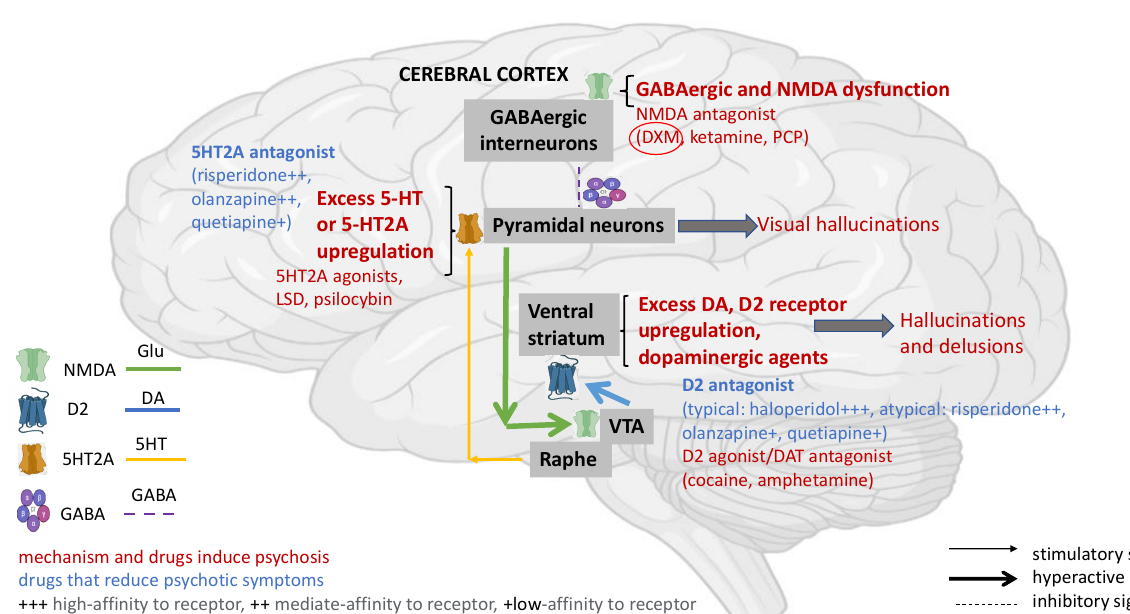
Figure 2. Potential drug-related psychosis pathways. Neurobiological and pharmacological evidence has revealed that psychosis symptoms, such as hallucination and delusions, are mediated by overactivation of the mesolimbic pathway, while visual hallucinations are consequences of visual cortex overstimulation. NMDA receptor dysfunction, excessive serotonin (5-HT) release, or 5-HT2 upregulation in the cerebral cortex may be the causes of further sustained activation of pyramidal neurons and diminished glutamatergic (Glu) input to the ventral tegmental area (VTA). Next, dopamine (D2) receptor upregulation and excessive dopamine (DA) release in the ventral striatum lead to hallucinations and delusions. Abused drugs and substances, including NMDA antagonists (i.e., dextromethorphan-DXM, ketamine, phencyclidine-PCP), psychedelic 5-HT-2A receptor agonists (i.e., lysergic acid diethylamide-LSD, psilocybin), psychostimulants—D2 agonist/DAT antagonists (i.e., amphetamine, cocaine), all have been reported to trigger hallucinations and delusions. Conversely, antipsychotics with both D2 and 5-HT2 high affinity have been shown to effectively treat drug-related psychotic symptoms. Adapted with modification from [46]. Created with